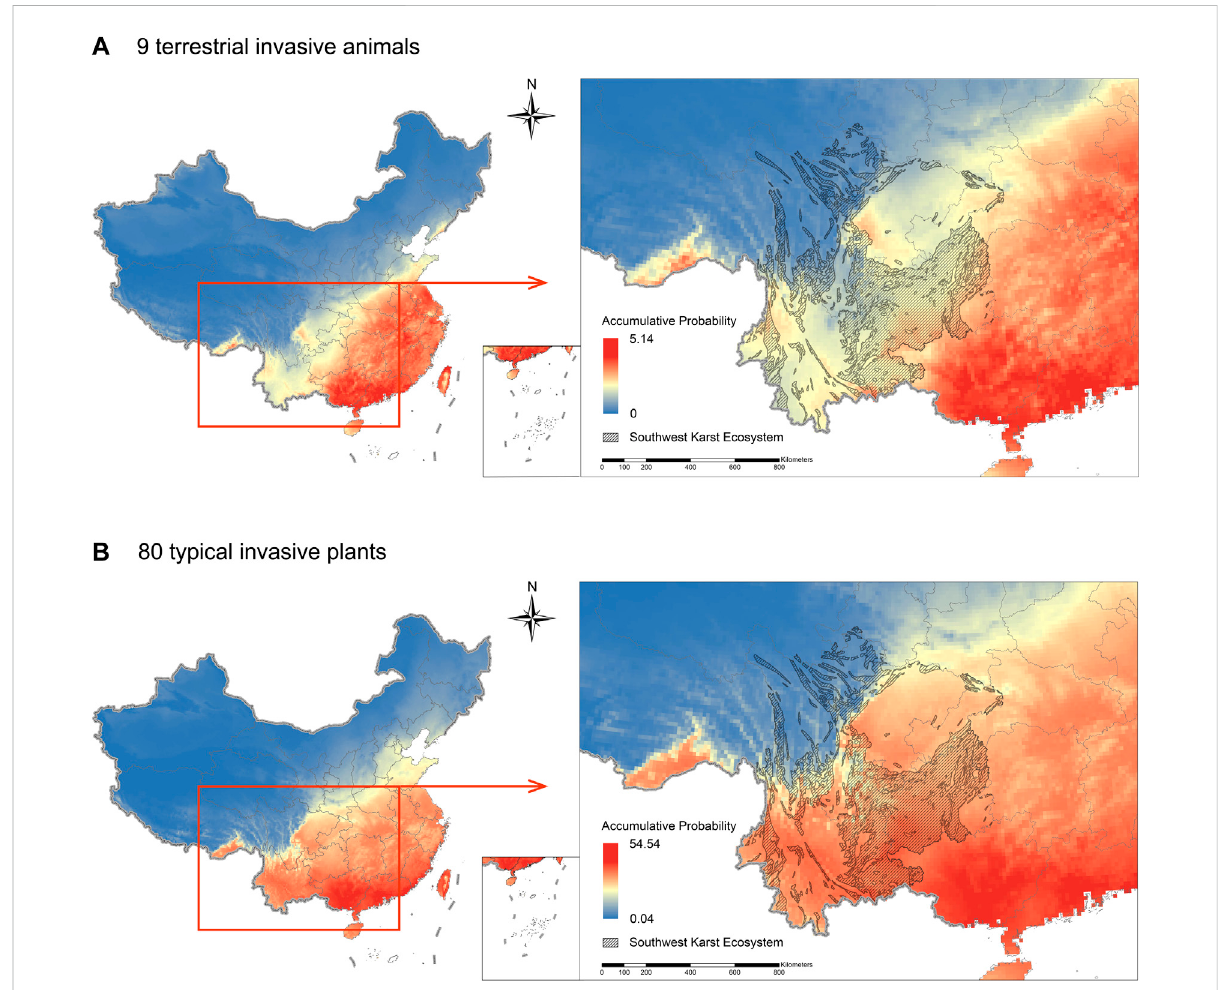
FIGURE 2 Accumulative potential distribution probability of typical invasive species in China predicted by the MaxEnt niche model. Blue represents grids with low probability which means low habitat suitability, red represents grids with high probability which means high habitat suitability. Crosshatch regions mean karst systems in southwest